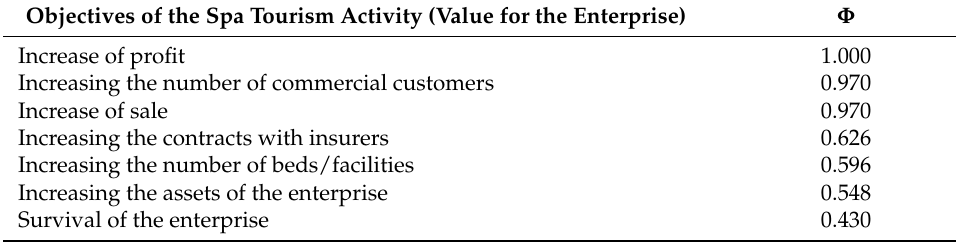
Table 2. Value for the enterprise resulting from the health resort activity. Objectives of the Spa Tourism Activity (Value for the Enterprise) Φ Increase of profit 1.000 Increasing the number of commercial customers Increasing the contracts with insurers Increasing the number of beds/facilities Increasing the assets of the enterprise Survival of the enterprise 0.430 Source: Based on own